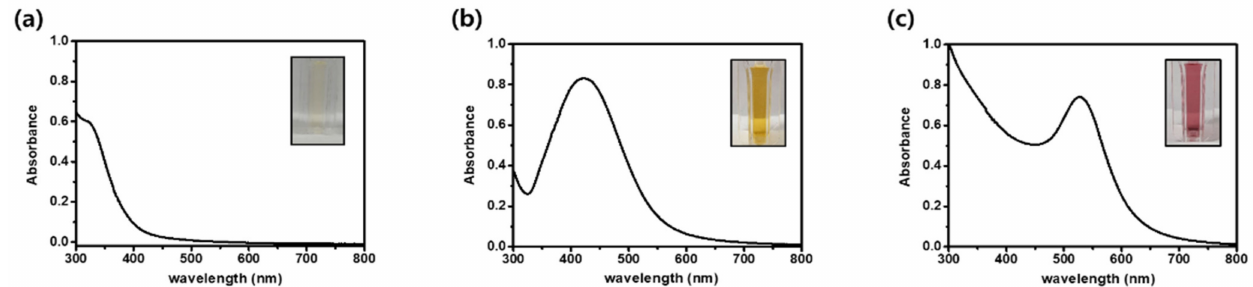
Figure 1. Ultraviolet–visible (UV–Vis) absorption spectra of ( a ) Sargassum serratifolium (SS) extract, ( b ) SS-AgNPs (SS-silver nanoparticles) and ( c ) SS-AuNPs (SS-gold nanoparticles).